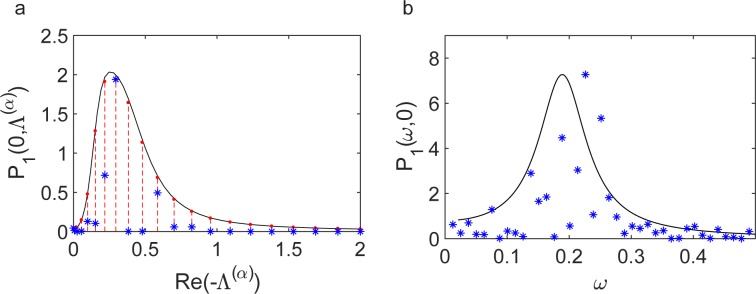
Power spectrum of the fluctuations.(a) Power spectrum evaluated at ω = 0 as a function of −Re(Λ(α)). The solid black line corresponds to the theoretical prediction on a continuous domain, and red points correspond to the theoretical formula using a filament with 40 cells. Blue stars stand for the power spectrum obtained from just one realization of the Gillespie algorithm. In the stochastic simulation, we used 40 cells and analyzed the recorded signal in the time interval τ [400,900] (see Fig 4G–4I). (b) Power spectrum evaluated at Re(Λ(α)) = 0 as a function of ω. The solid black line is the analytical theory, while blue stars correspond to the stochastic simulation. Theoretical and numerical profiles are normalized so as to yield the same maximum value (using the discrete theoretical curve for the spatial slice). Parameters are the same as those in Fig 4G–4I. The data used in this figure are included in S1 Data.